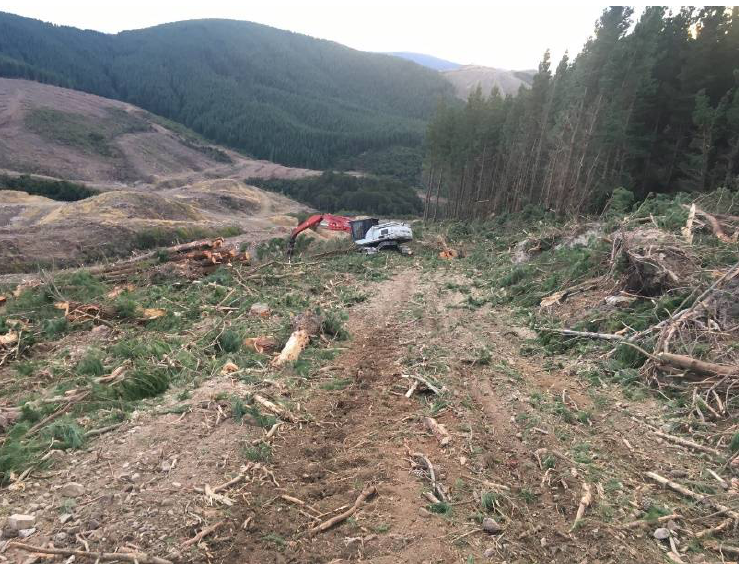
Figure 5. Skid trail A in operation, leading down to the shovel. The deep disturbance measure was almost exclusively from the main skid trails.